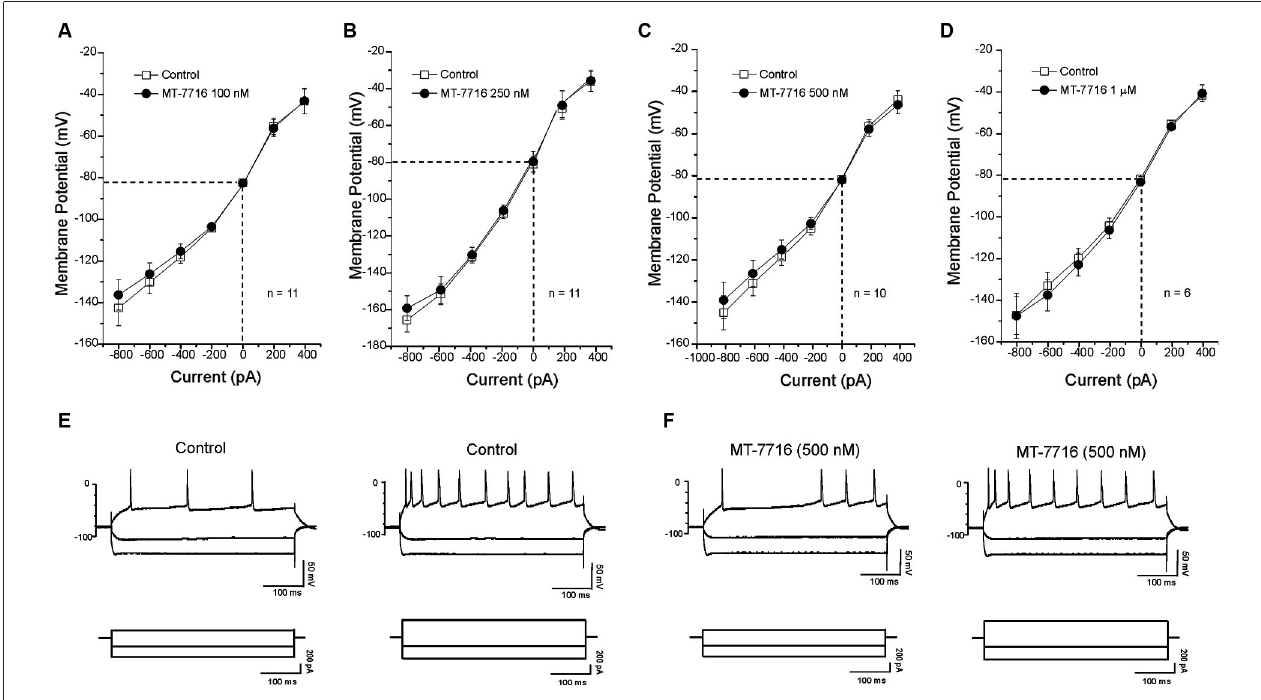
and 6 CeA neurons tested with 500 nM and 1000 nM MT-7716 was − 81.5 ± 0.9 mV (C) and − 81 ± 1.2 mV (D) . (E) Representative current clamp recordings of a CeA neuron (RMP = 80 mV; input resistance 113 M) during control and 500 nM MT-7716 superfusion (F) . Overall, MT-7716 did not significantly affect the firing pattern or number of action potentials in our CeA neuronal